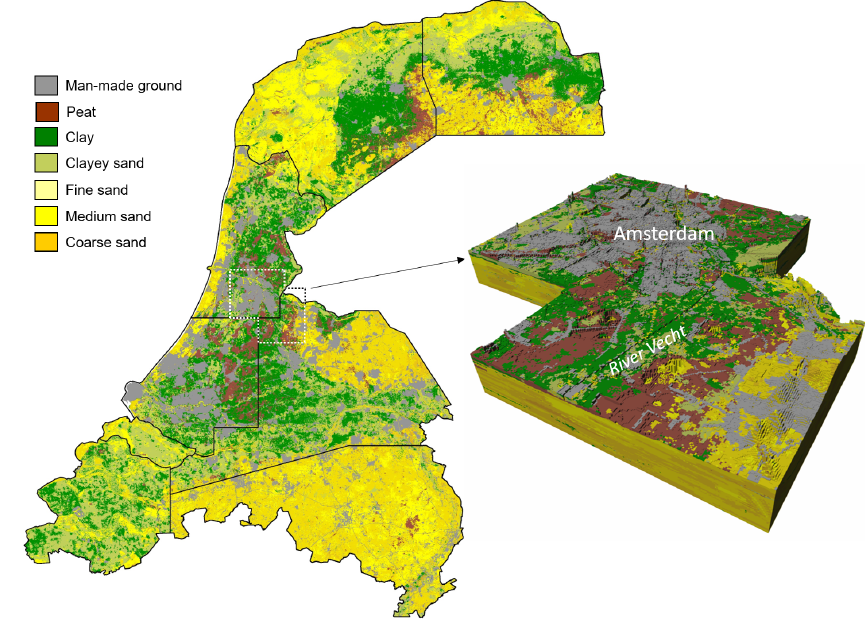
Figure 1. GeoTOP illustration of the Netherlands (left) and an enlarged area around Amsterdam (right).